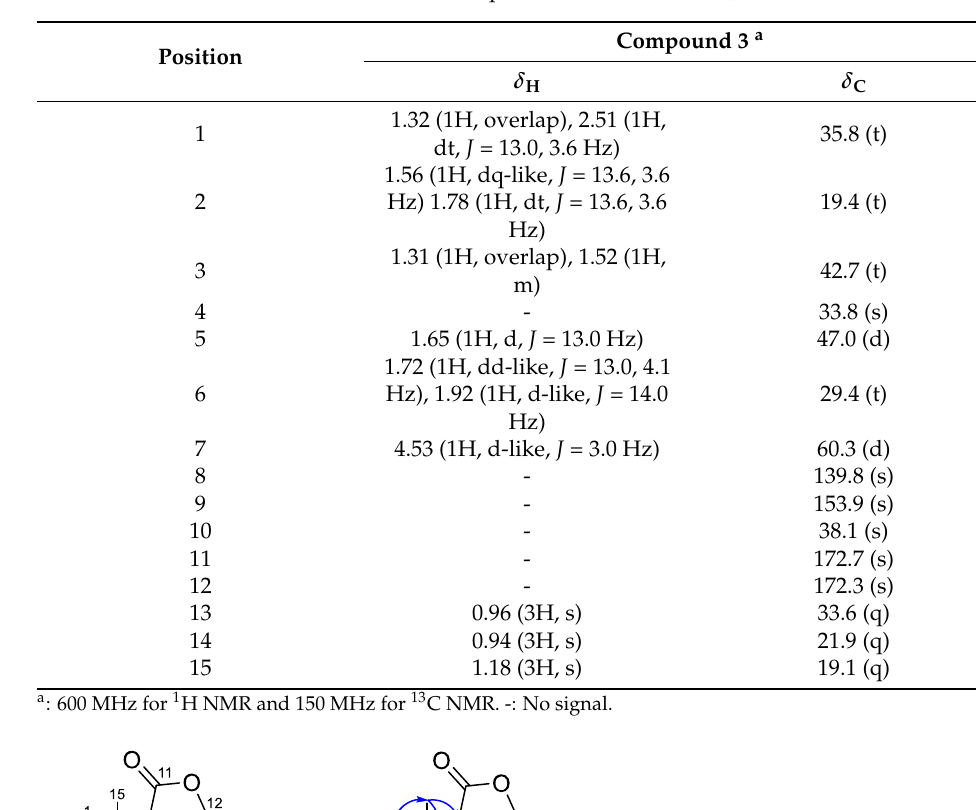
Table 3. 1 H-NMR and 13 C-NMR data for compounds 3 in methanol- d 4 .